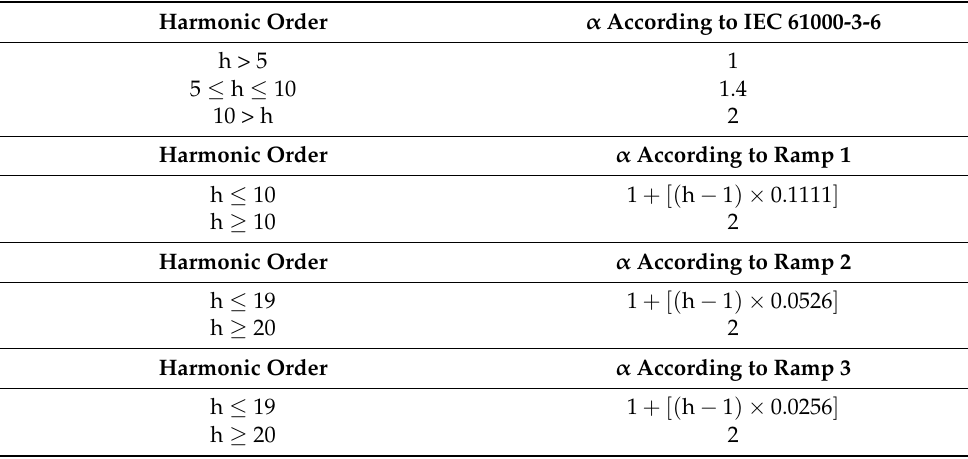
Table A6. Aggregation exponent for harmonic